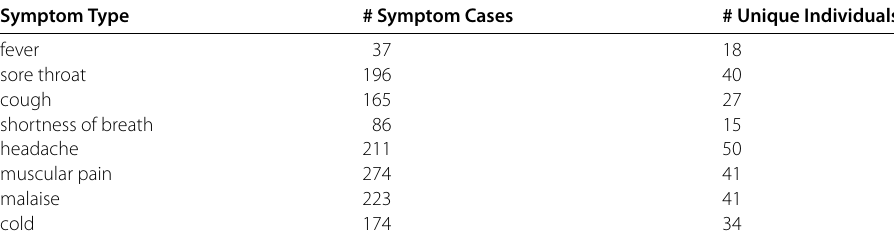
Table 2 Description of the different Symptom Types, the number of cases that were present and the unique number of individual reporting each symptom Symptom